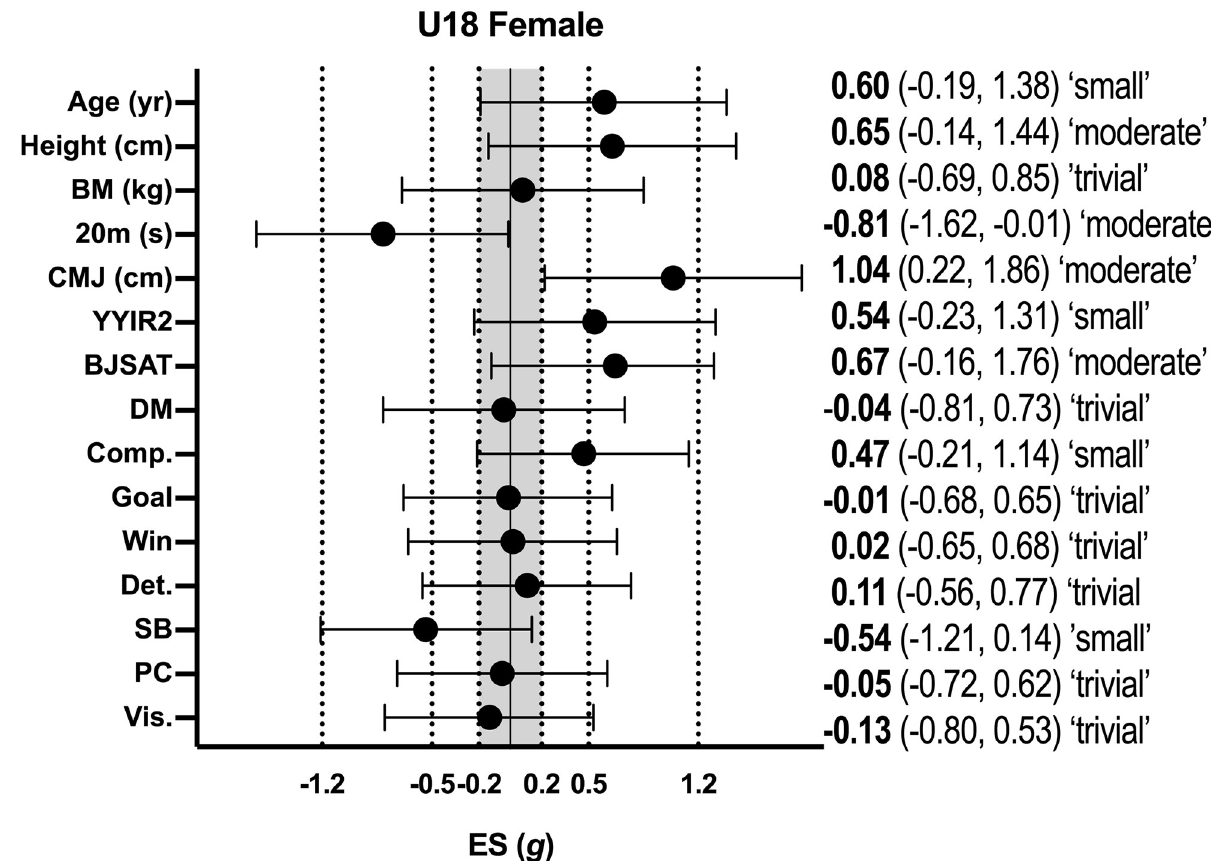
Fig 4. Effect sizes between selected and non-selected female U18 basketballers. BM–body mass; CMJ–countermovement jump; YYIR2 –Yo-Yo Intermittent Recovery Test Level 2; BJSAT–Basketball Jump Shooting Accuracy Test: DM–decision-making; Comp–competitiveness; Det.– determination; SB–self-belief; PC–positive cognition;